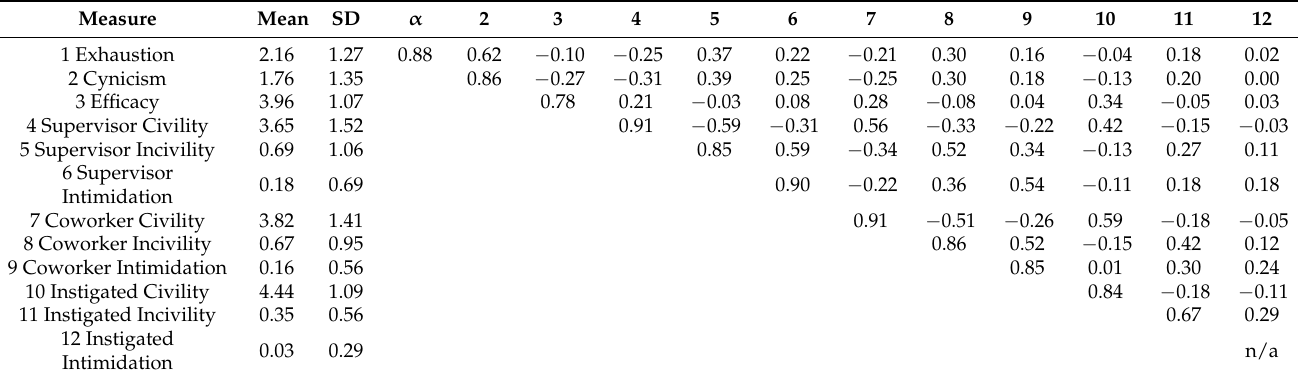
Table 1. Means, standard deviations, alphas, and Correlations among variables at Time 1. Measure Mean SD α 2 3